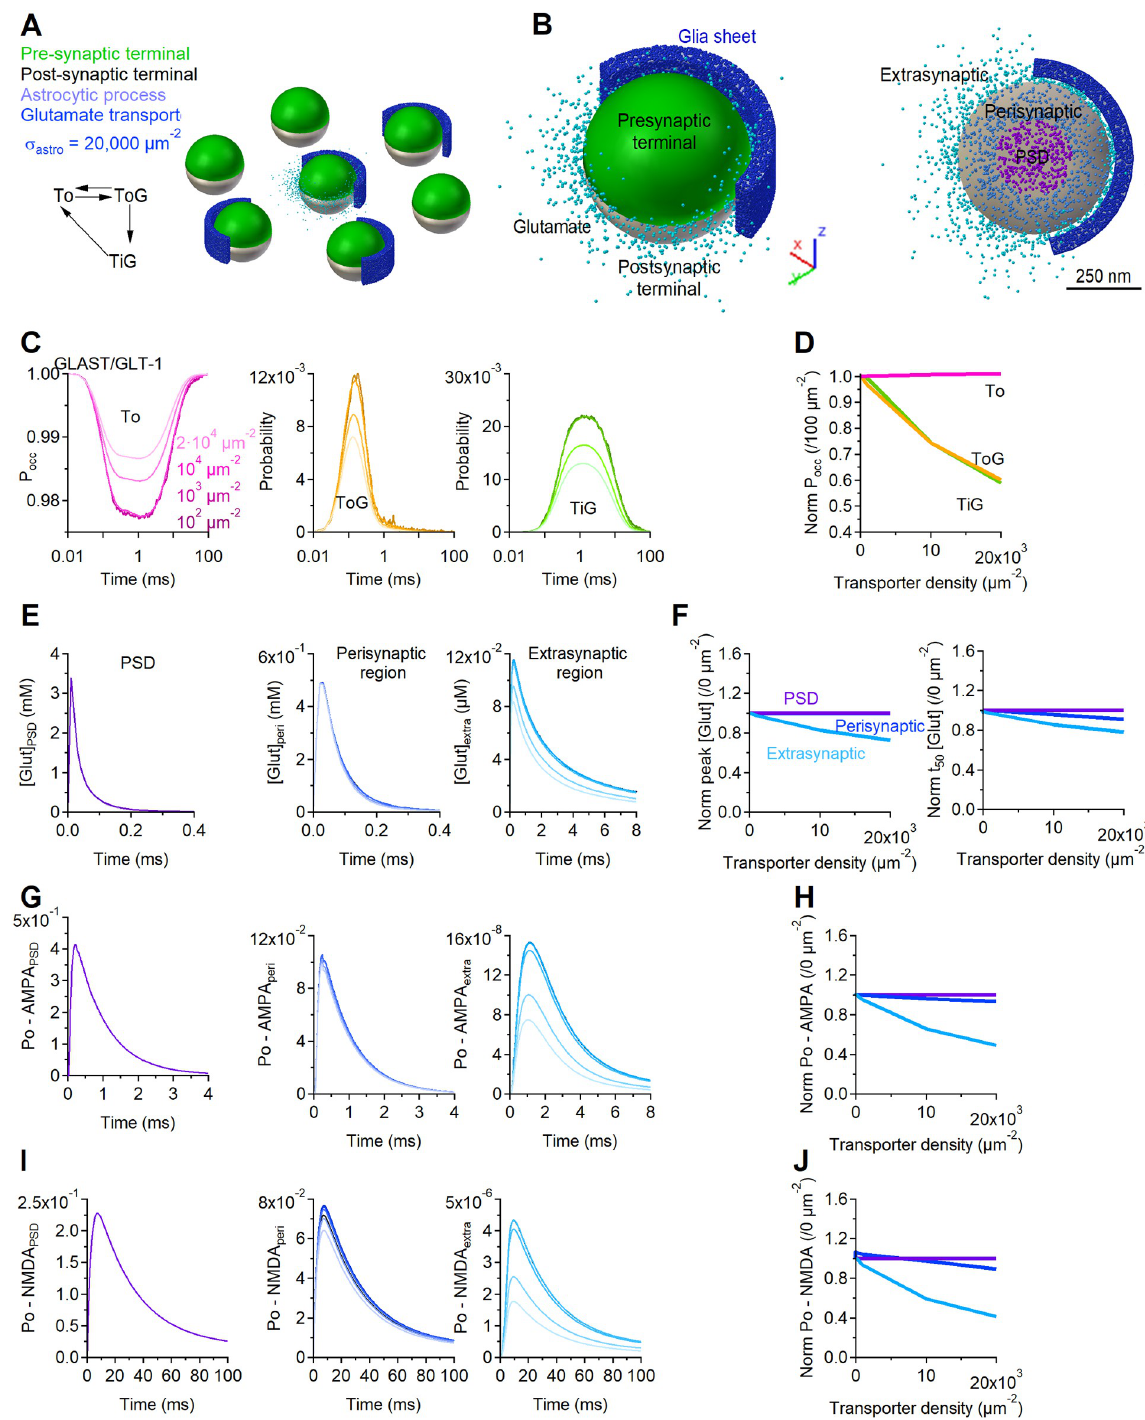
Fig 6. Varying the glutamate transporter surface density alters extra-synaptic receptor activation. A . 3D representation of the geometries of seven neighboring synapses used to run the 3D Monte Carlo diffusion model. The kinetic scheme of glutamate transporters, on the left hand side, has the following kinetic: k To ! k ToG = 18 � 10 6 M − 1 s − 1 ; k ToG ! k To = 3, 594 s − 1 ; k ToG ! k TiG = 6 � 10 3 s − 1 ; k TiG ! k To = 150 s − 1 . B . Left , Close-up view of an individual synapse, composed of a hemispheric pre- ( green ) and post-synaptic terminal ( white ), with 57% of its perimeter surrounded by an astrocytic process, populated with glutamate transporters ( blue ). Glutamate molecules can be seen diffusing out of the synaptic cleft ( cyan ). Right , Close-up view of the synaptic cleft. Glutamate molecules diffusing in the PSD ( purple ) and perisynaptic portion of